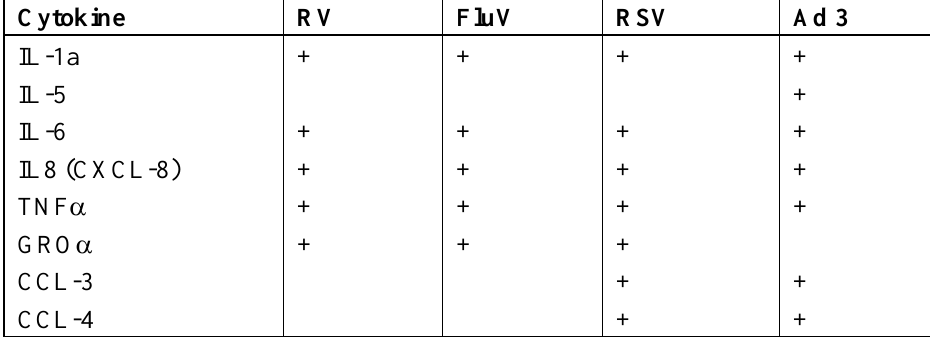
Table 5. Cytokines/chemokines induced by viruses (+) and reversed by Echinaforce ® . Cytokine